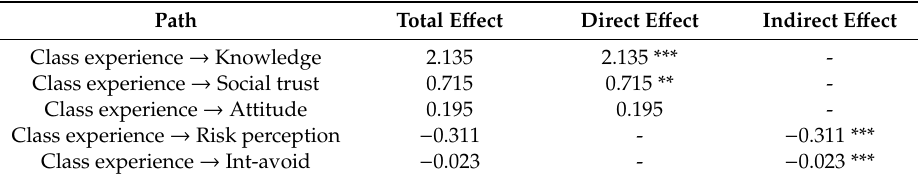
Table 5. Decomposition of e ff ect of class experience on other